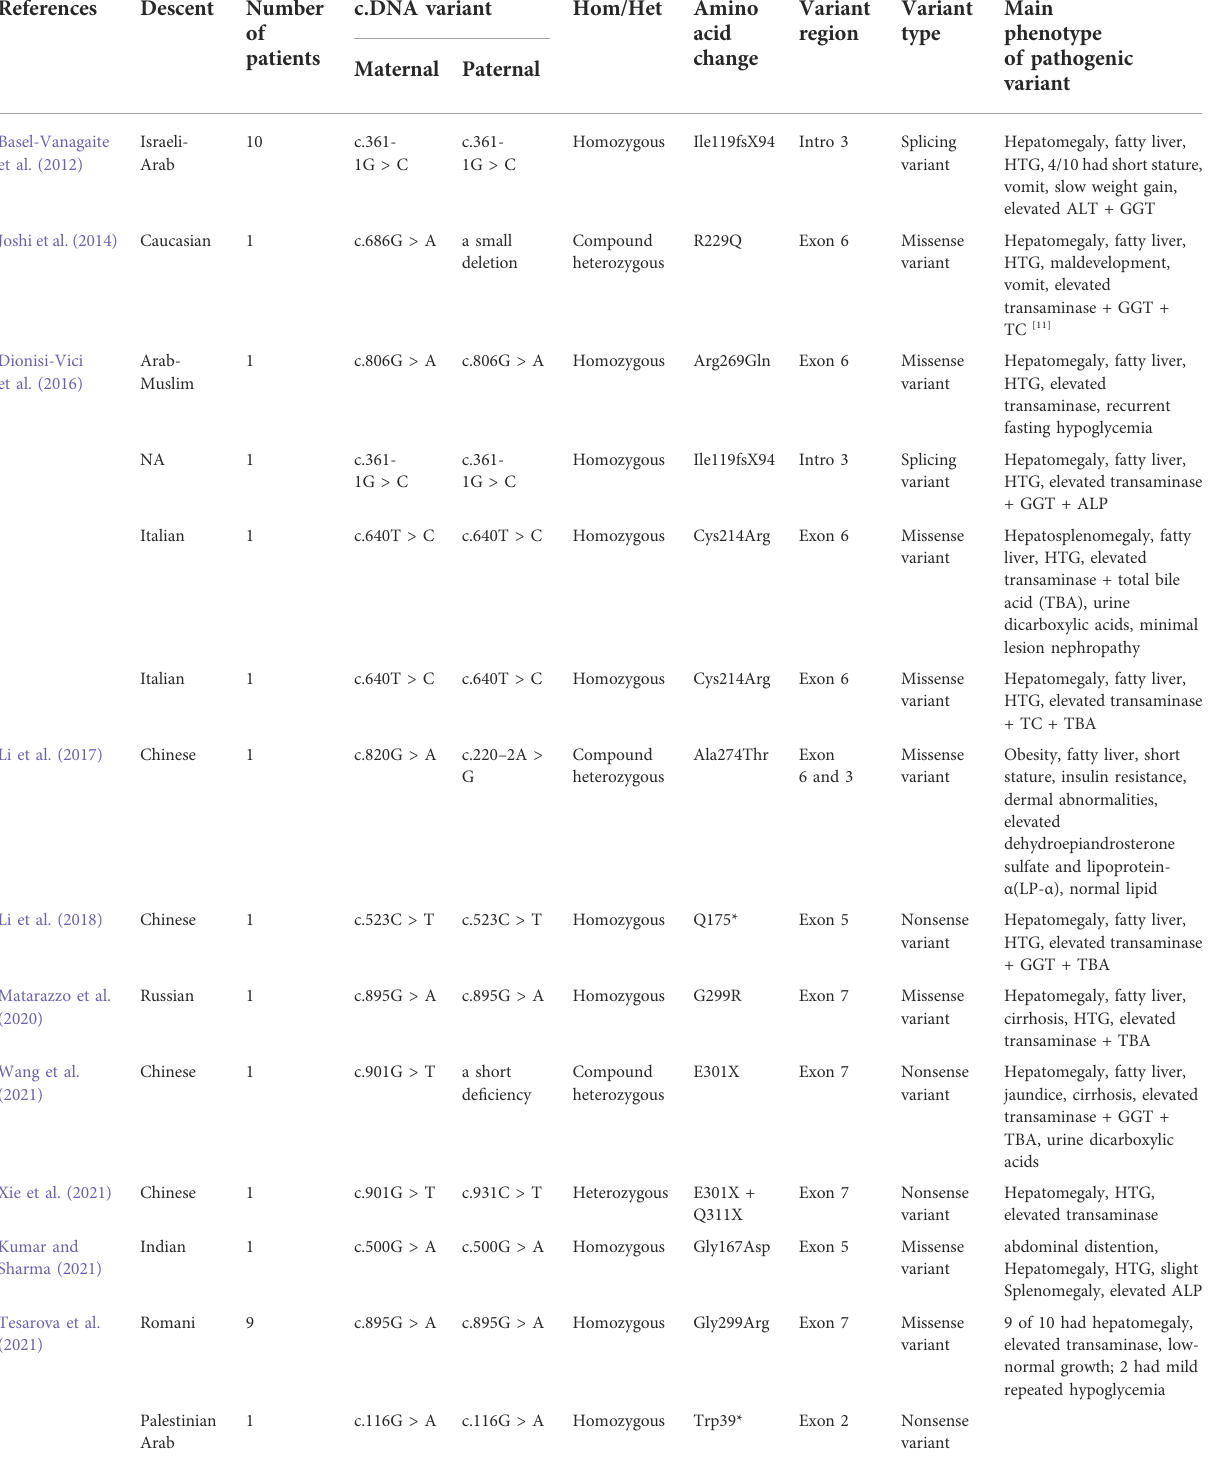
TABLE 1 GPD1 gene variant and phenotype of 31 patients with